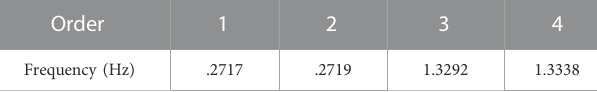
TABLE 1 The fi rst four natural vibration frequencies of wind turbine. Order